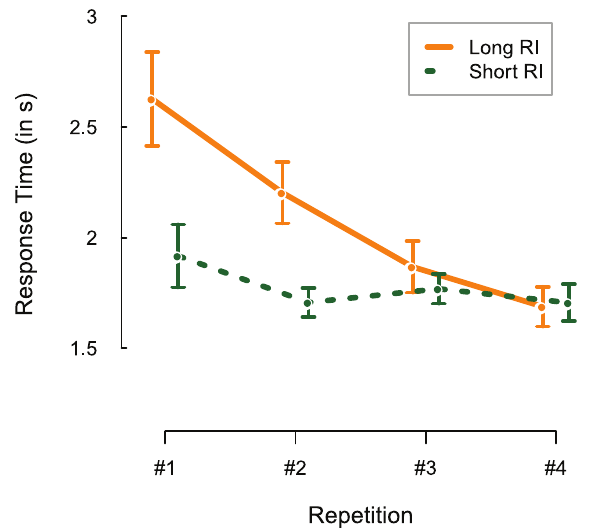
Figure 4. Response latencies per repetition, plotted separately for the long (orange, solid) and short (green, dashed) retention interval (RI) sets. Error bars represent 1 standard error of the mean.